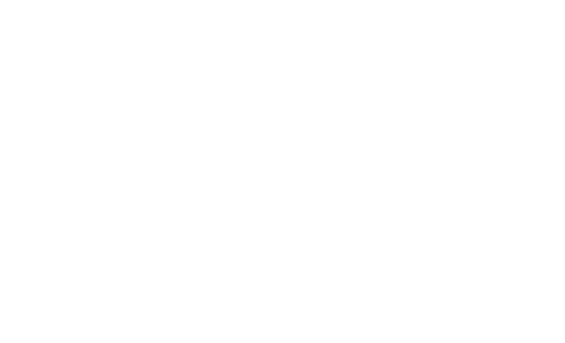
Figure 1. Snapshot of the rotating drum obtained with MercuryDPM. The imposed transverse forcing is along the x − direction, such that the movement of the walls is x ( t ) = A sin ( 2 π ft ) . In this case, (cid:31) = 1 rpm and A = 0 .